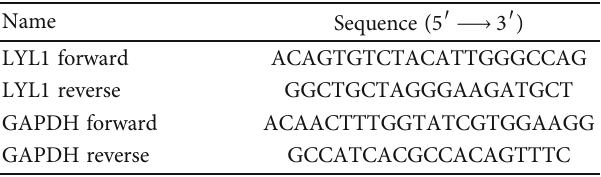
Table 2: Primers used for qRT-PCR analyses.